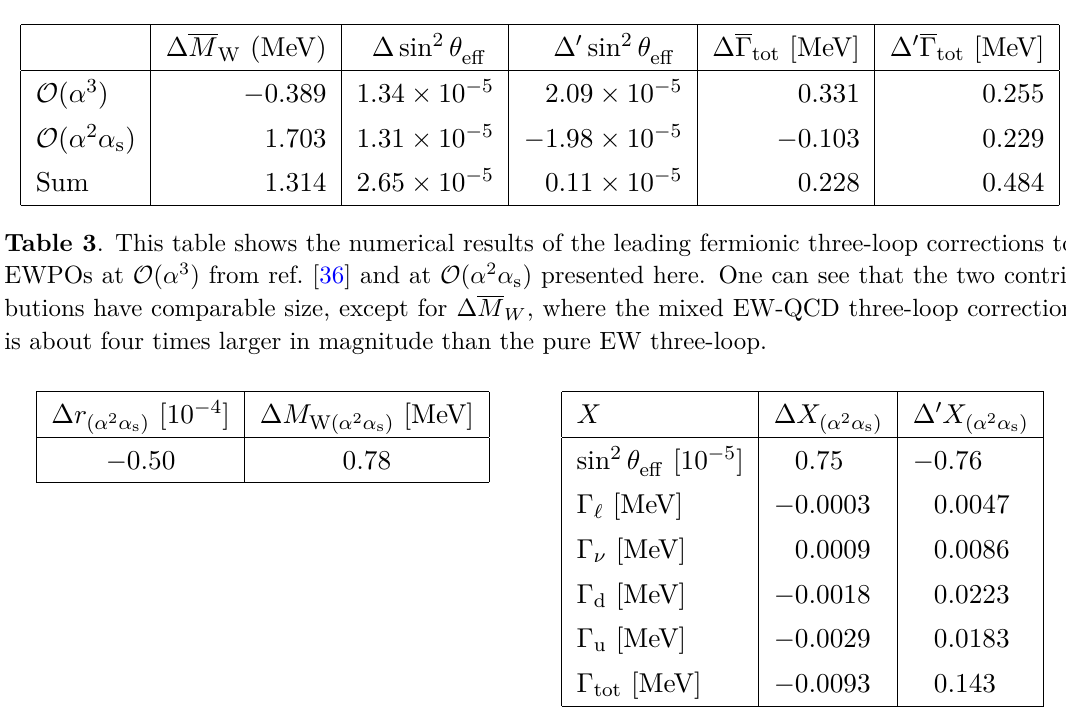
Table 2 . This table demonstrates the future experimental accuracies projected for CEPC, FCC-ee, and ILC for three EWPOs [31–34]. For ILC, the GigaZ option is considered, which is a Z -pole run with 100 fb − 1 .